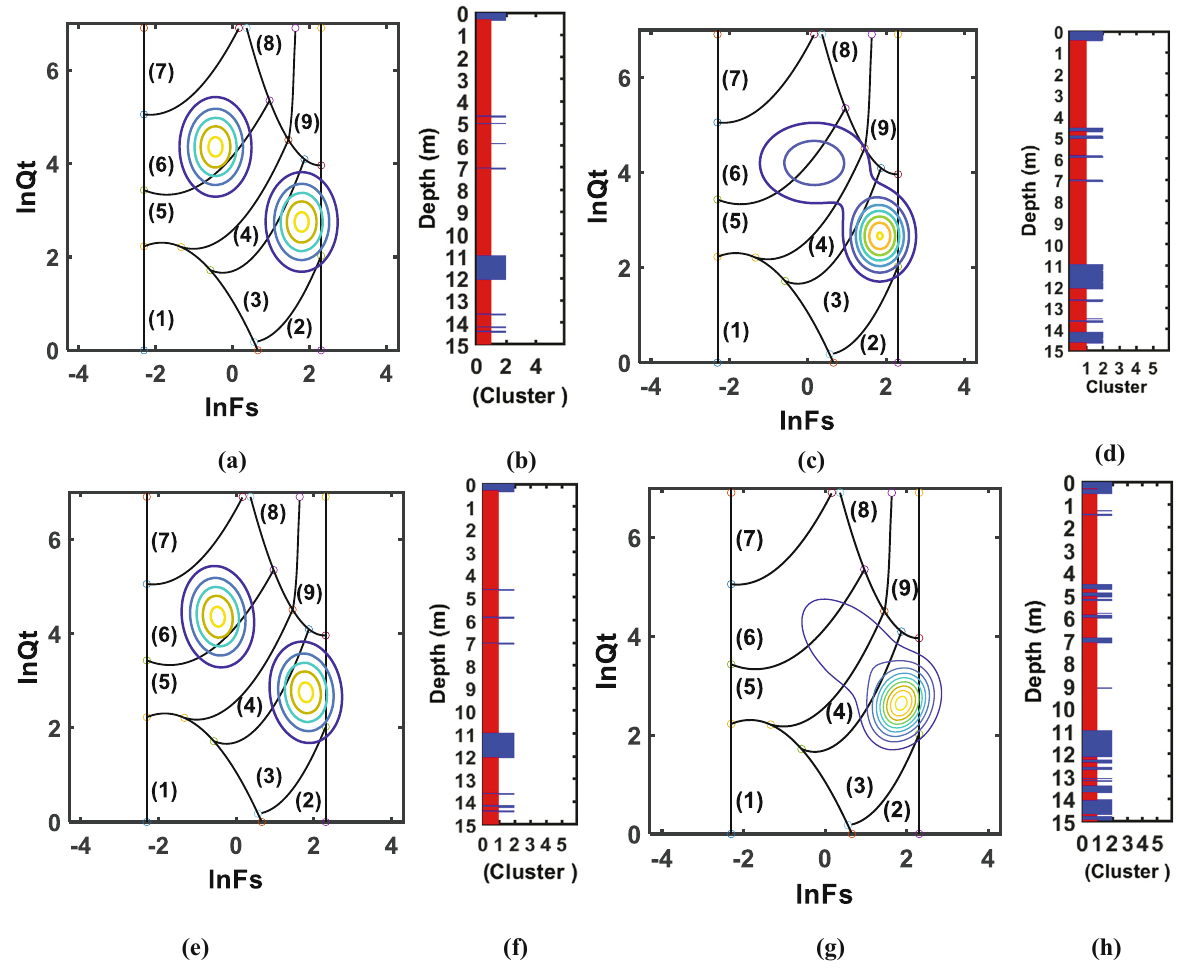
Figure 6: Feature and physical patterns of the CPT1 using four types of covariance: ( a ) feature spatial of CPT1, true DC, two clusters; ( b ) physical spatial of CPT1; ( c ) feature spatial of CPT1, false DC, two clusters; ( d ) physical spatial of CPT1; ( e ) Feature spatial of CPT1, true full covariance, two clusters; ( f ) physical spatial of CPT1; ( g ) feature spatial of CPT1, false full covariance, two clusters; and ( h ) physical spatial of